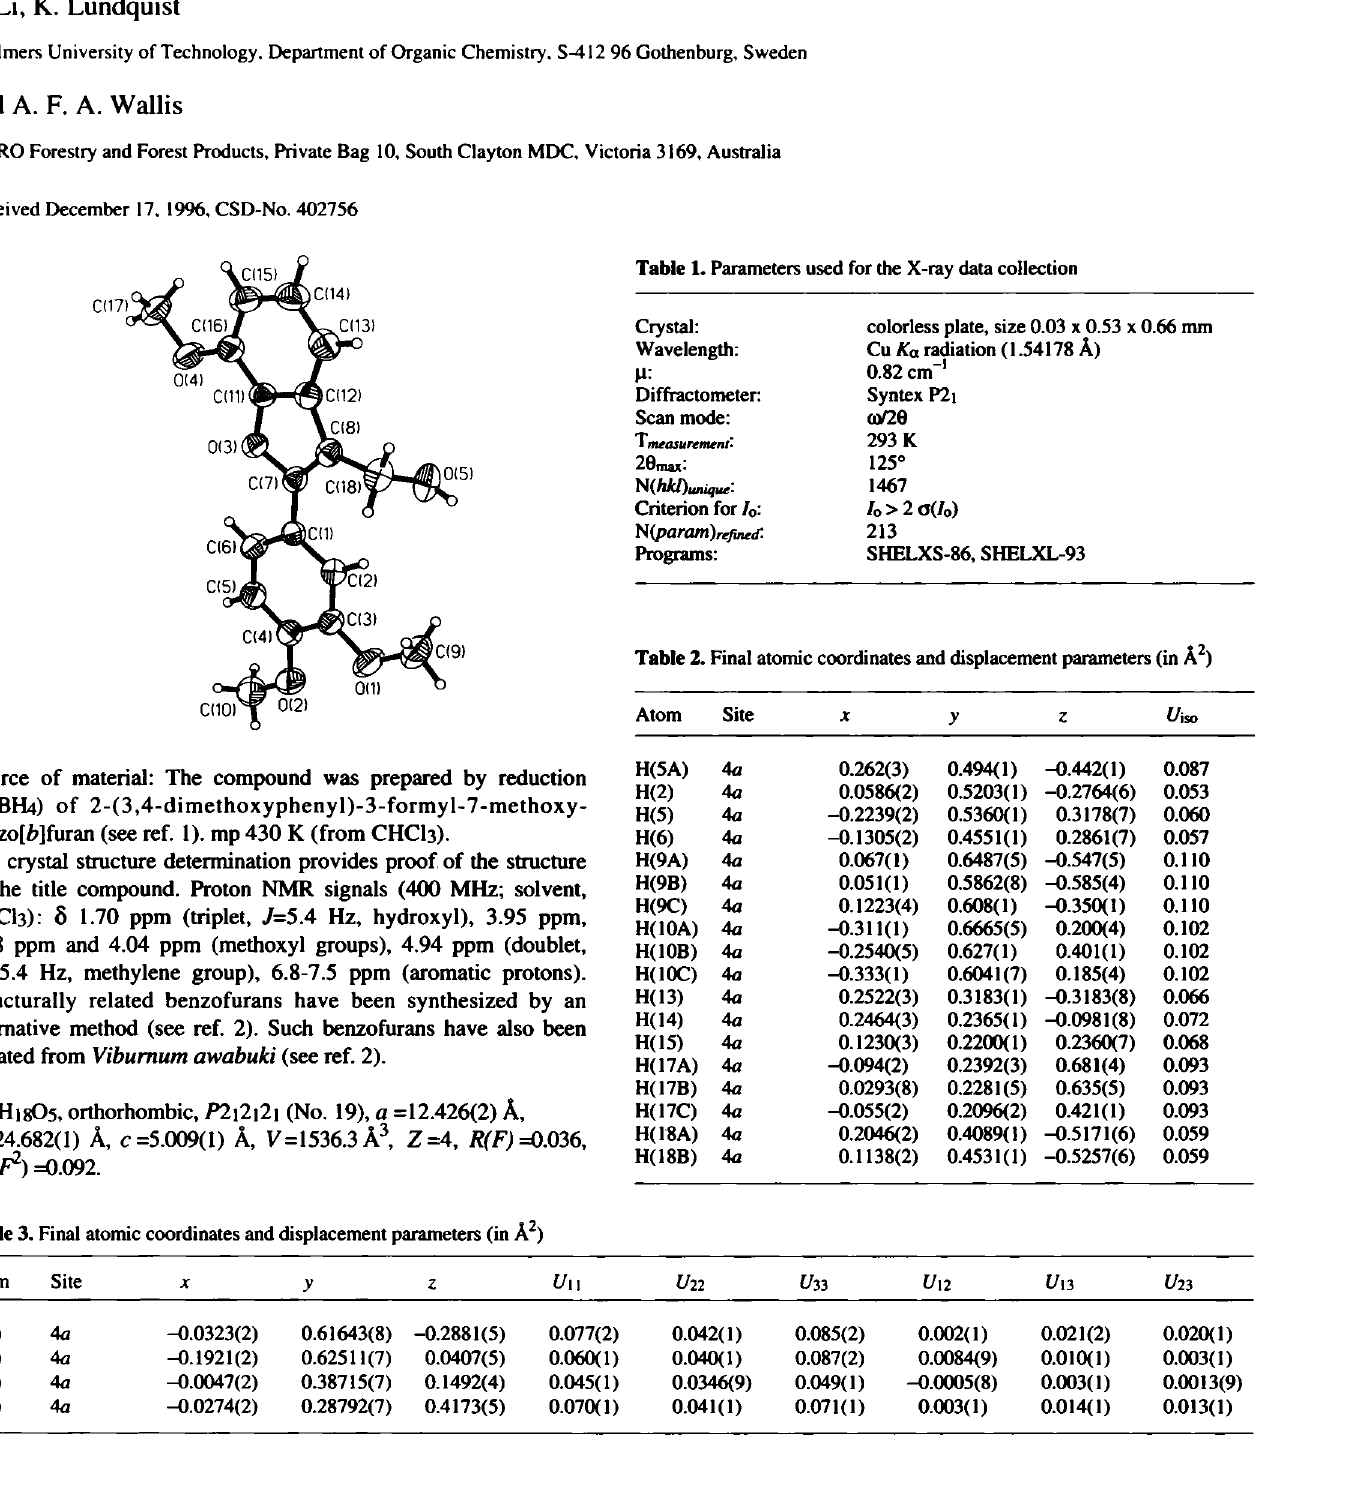
Table I. Parameters used for the X-ray data collection